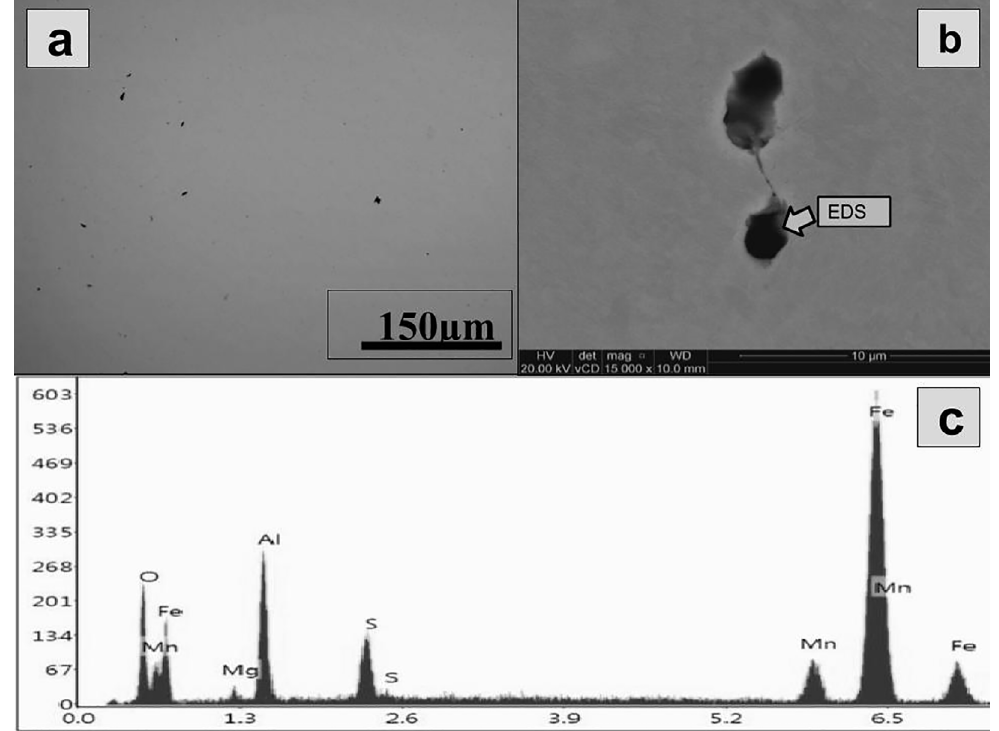
Figure 2. Optical microscopy image of the inclusions distribution in the microstructure of the API 5L X80 steel (a), representative EDS spectrum of the inclusions (b), and backscattered SEM image of an irregular-shaped inclusion (insert in (a)).